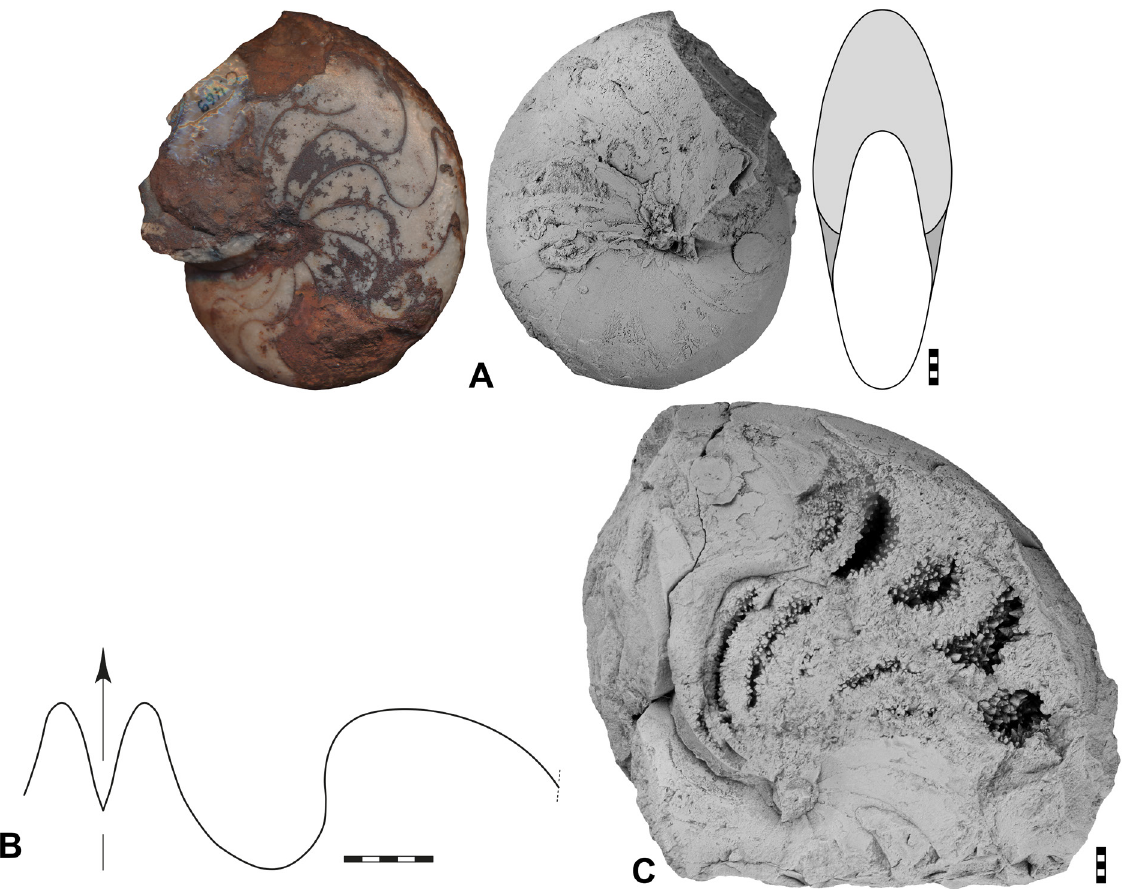
Fig. 7. Epitornoceras mithracoides (Frech, 1888), specimens from the Volpertseiche Mine near Oberscheld (both Koch Coll.). A . Lectotype (MB.C.469). B . Suture line of lectotype (MB.C.469); at dm = 43.5 mm; ww = 15.0 mm; wh = 25.5 mm. C . Paralectotype (MB.C.470). Scale bar units = 1